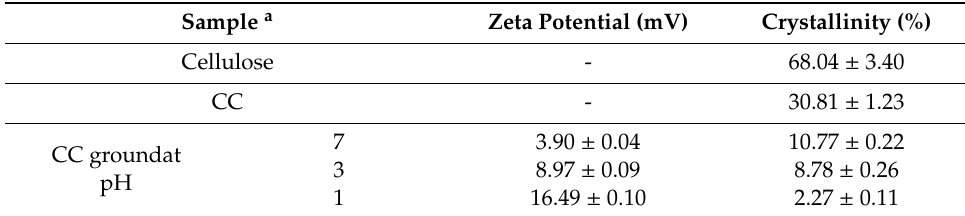
Table 2. The crystallinity of cellulose before and after modifications and zeta potential in supernatant of the CC (DS = 0.123) after grinding at different pH values.